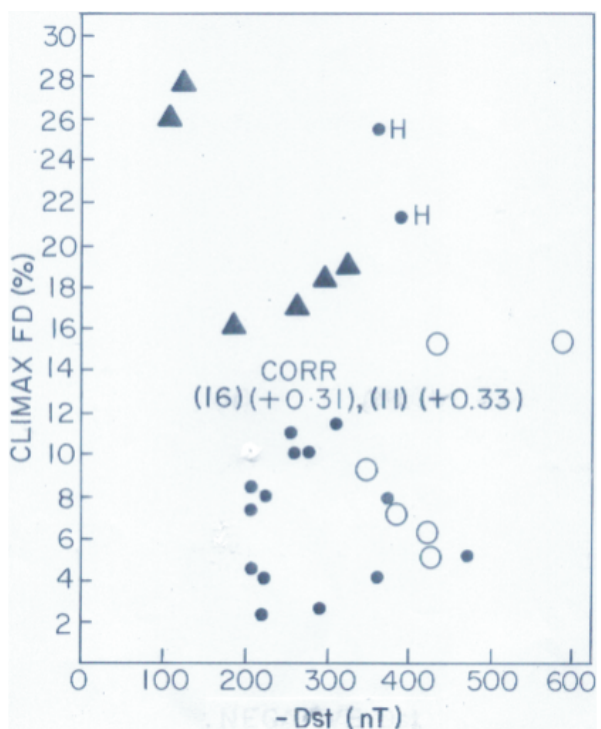
Fig. 6. Plot of Climax FD magnitudes versus maximum negative Dst for seventeen severe Dst events in cycle 23 (dots), for six largest Dst events in cycles 19–22 (open circles) and for six largest FDs in cycles 19–22